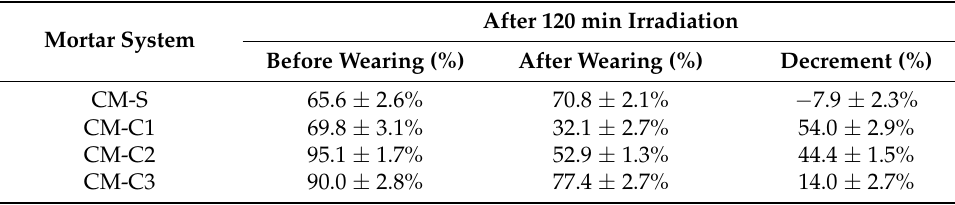
Figure 8. Elemental distribution of Ti and Ca on CM-S mortar surface before and after wearing. 2.5. Proposed Mechanisms The photocatalytic MB degradation before and after wearing indicates well that the introduction of TiO 2 @CoAl-LDH nanospheres into cementitious composites can produce a stable system involving surface mechanical properties and the distribution of pores and hydrates, even if this creates low but acceptable photocatalytic capacity. A proposed mechanism for enhancing the photocatalytic capacity of smeared mortar is as follows: on the one hand, the TiO 2 @CoAl-LDH nanosphere has a high specific surface area and vol- ume ratio, which can accelerate the formation of the main cement hydration products (e.g., needle-like AFt, CH, and C-S-H), thereby enhancing the overall performance of the ce- ment mortar. This can be regarded as an important indicator of the good compatibility between the photocatalyst and the cementitious substrate [5,36]. On the other hand, the stacking interaction between the TiO 2 @CoAl-LDH nanospheres and needle-like hydration